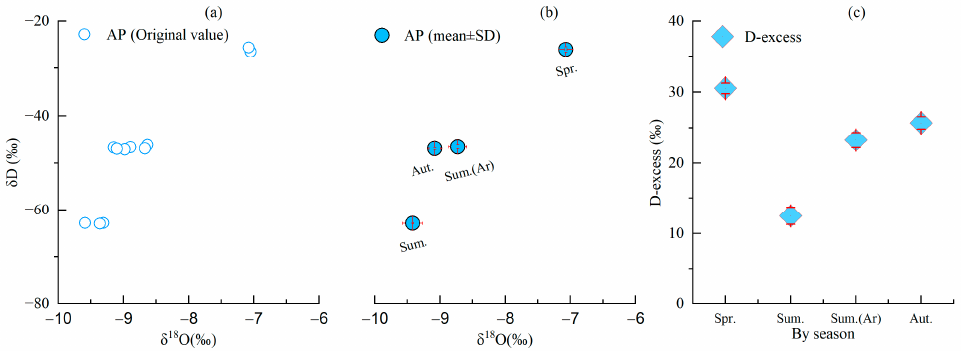
Figure 4 . Seasonal variation in ( a ) δ D and δ 18 O original values, ( b ) average value of δ D and δ 18 O original values and ( c ) d-excess value in terms of atmospheric precipitation and d-excess (‰). Red line stands for positive (upper and right) and negative (down and left) standard deviation.